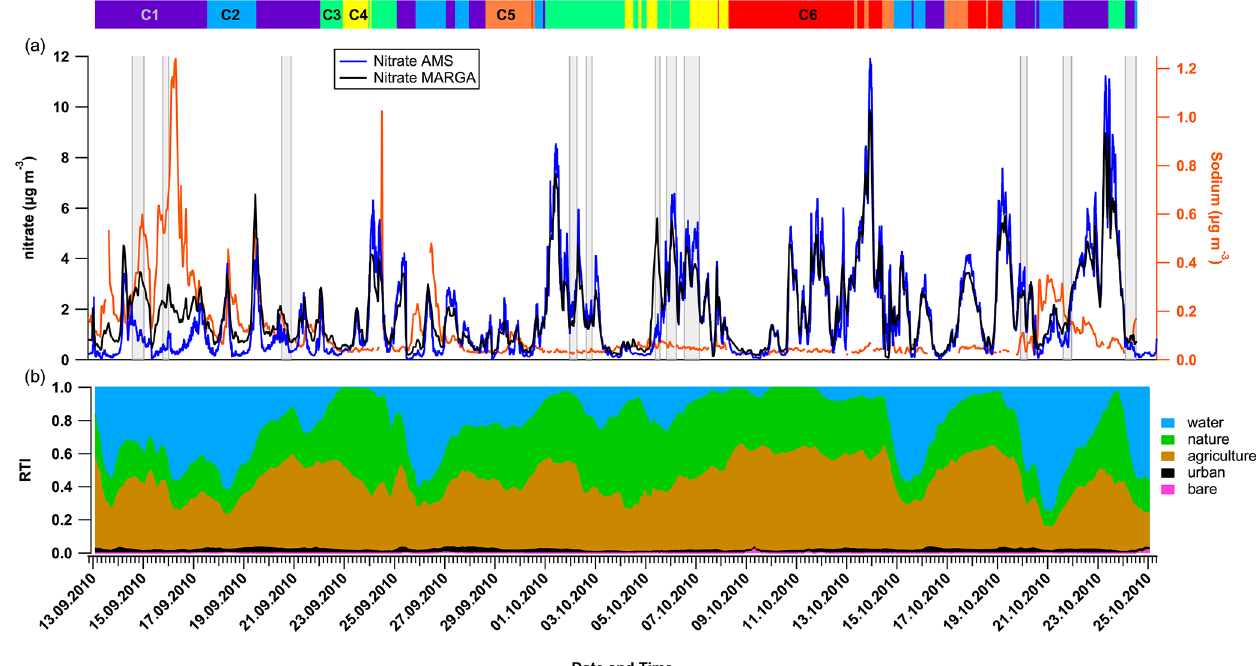
Figure 3. Influence of marine air masses on nitrate size distribution. (a) Nitrate mass concentrations measured by AMS and MARGA and sodium mass concentrations by MARGA. (b) The residence time index (RTI) of the 96h backward trajectories above different land cover, as developed by van Pinxteren et al. (2010). The colored bars and numbers at the top refer to the six different air mass clusters (see Sect. 3.4), and the gray bars refer to the different cloud and non-cloud events, as defined in Table